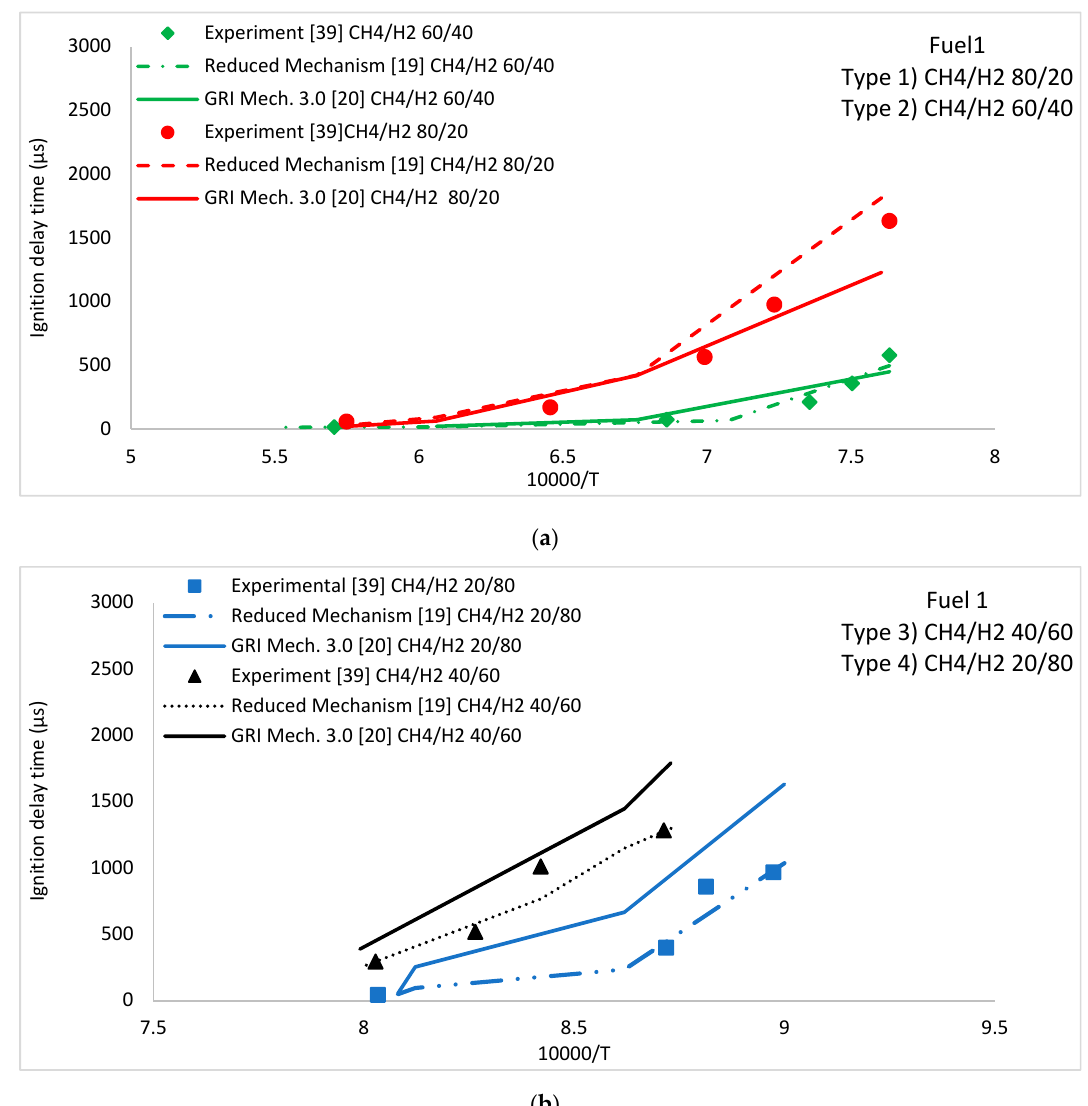
Figure 3. Comparison of the calculated ignition delay time by using the reduced mechanism [19] and GRI Mech. 3.0 [20] and the experimental measurements from Reference [39] for ( a ) Fuel 1 Type 1 and Type 2; and ( b ) Fuel 1 Type 3 and Type 4 at pressure 20 bar and equivalence ratio 0.5.